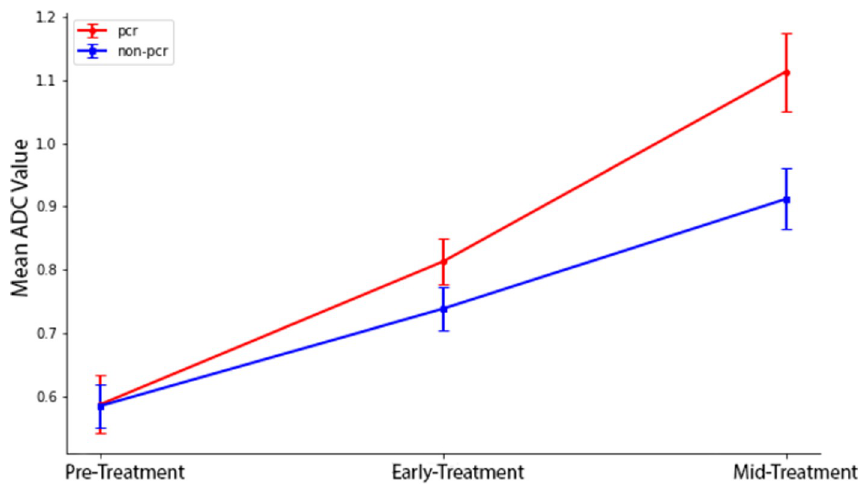
Fig 6. Mean ADC values for all non-pCR and pCR patients at the pre-treatment, early treatment, and mid- treatment time points. Error bars are standard deviations. pCR: complete pathological response.